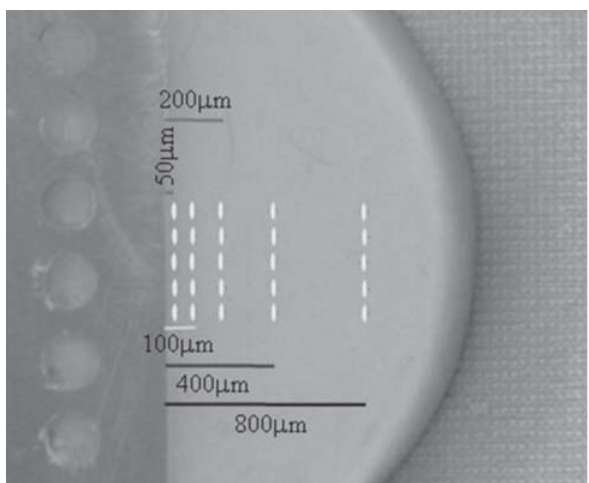
FIGURE 2- Locations of Knoop penetrations from the Co- Cr metal